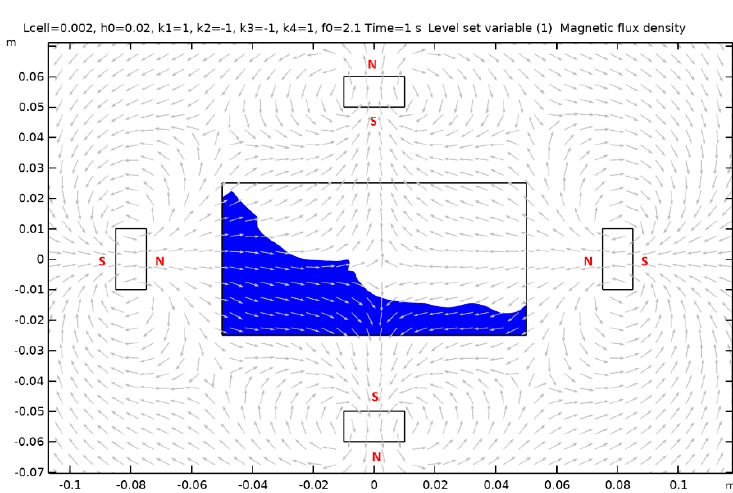
Figure A8. Case 9. Figure A8. Case 9.